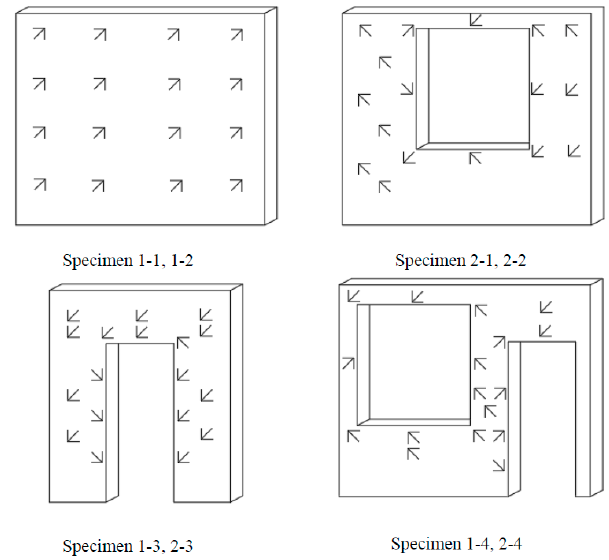
Figure 6. The layout of the strain gauges.